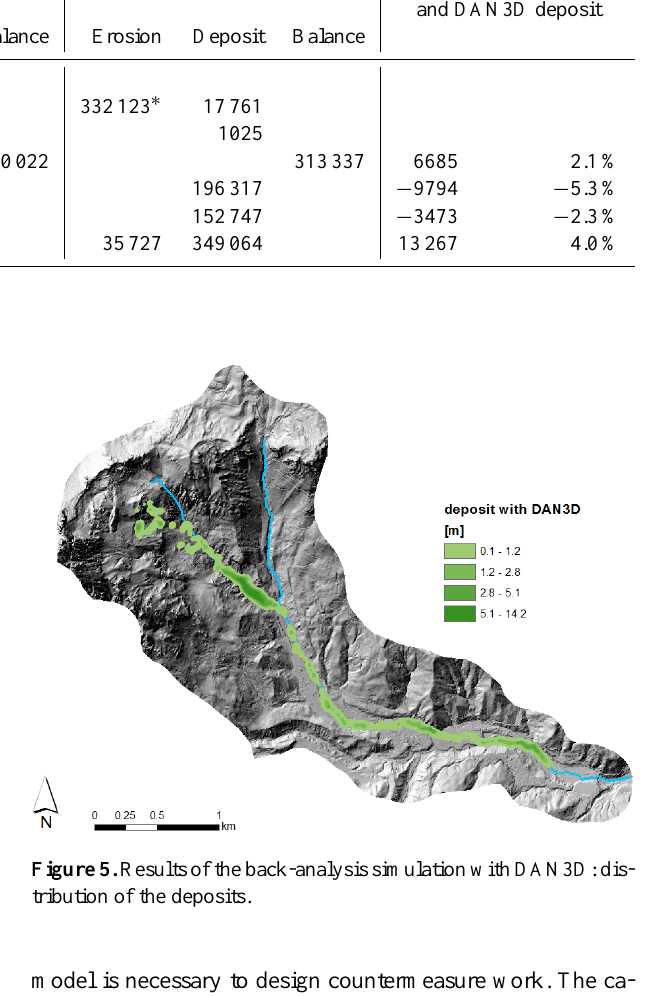
Table 2. Comparison, in terms of volume, of the main results of the DoD analysis and the DAN3D simulation. Volume [m 3 ]